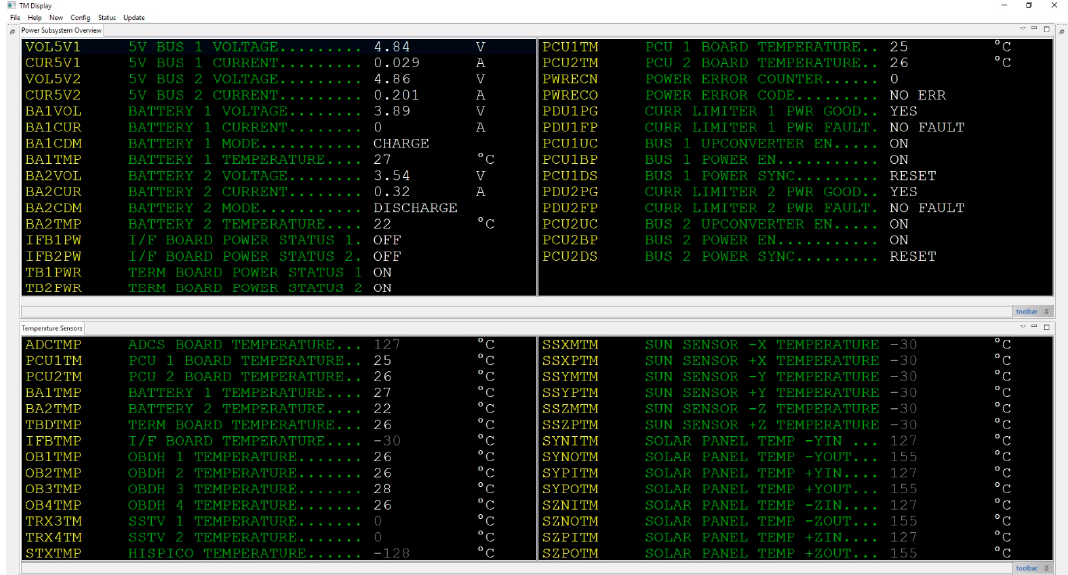
Figure 1. Telemetry client displaying two telemetry pages of housekeeping data.